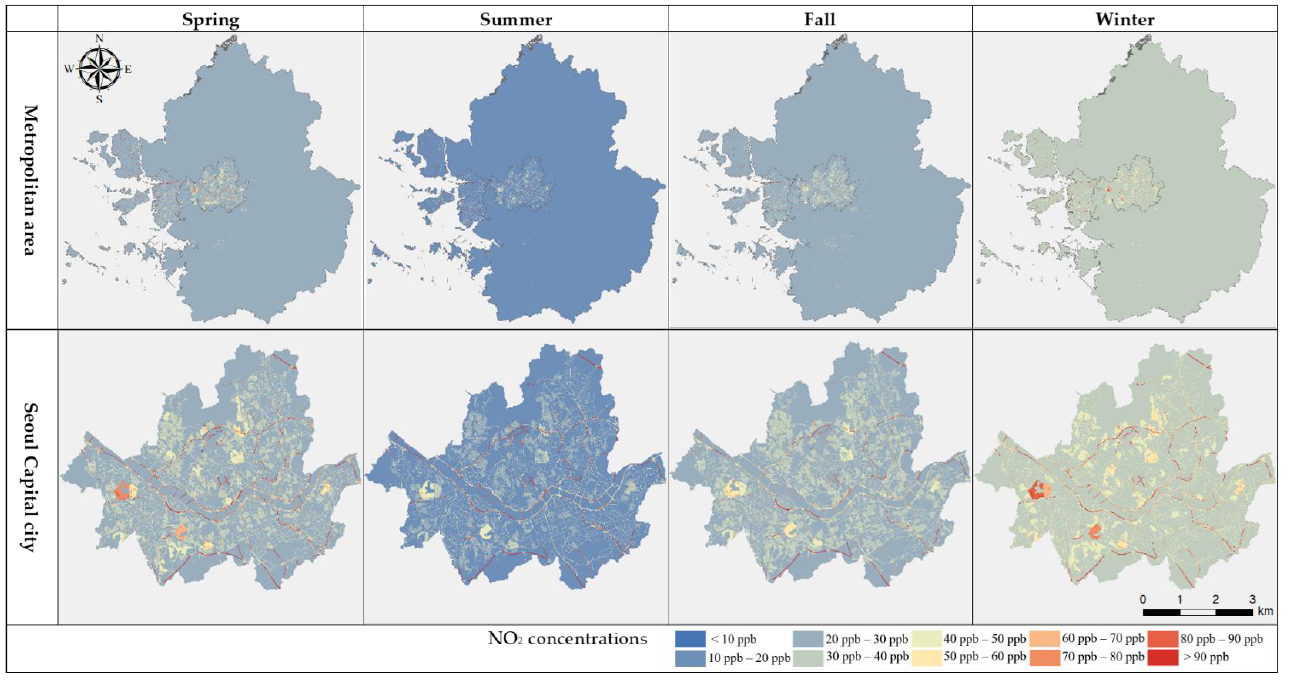
Figure 2. Present (2018) LUR seasonal models of the whole study area (Metropolitan area) and Seoul capital city.